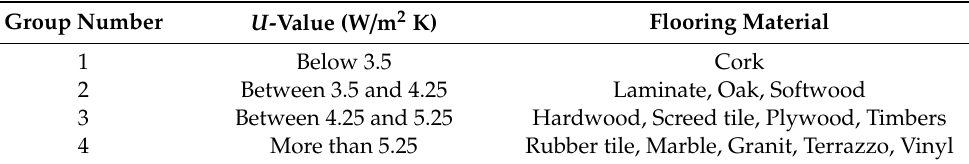
Table 10. The studied flooring materials’ U